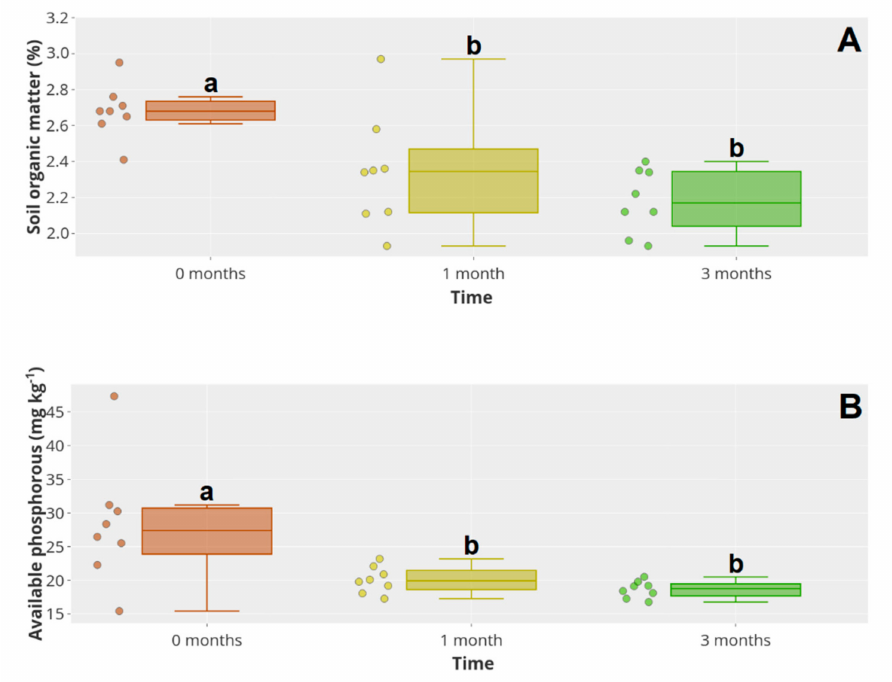
Figure 4. Di ff erences in soil chemical properties within the fig orchard study site over the study period: ( A ) soil organic matter and ( B ) available phosphorus according to the time after tillage. Upper hanging bar (maximum), lower hanging bar (minimum), upper box line (quartile 3), line (median), and lower box line (quartile 1). Di ff erent lower-case letters represent significant di ff erences between treatments ( p < 0.05). Dots next to a boxplot represent measured